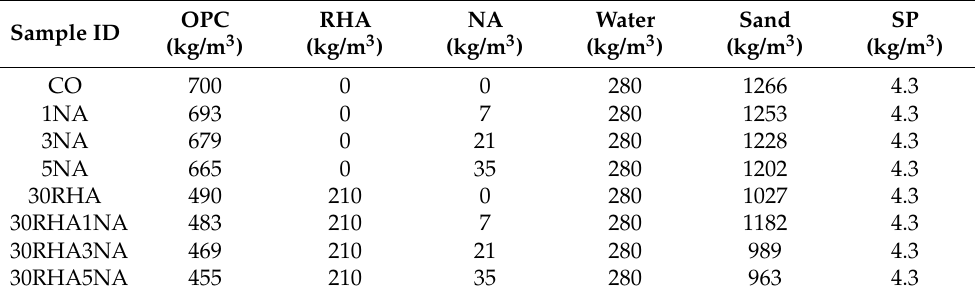
Table 3. Mix design of